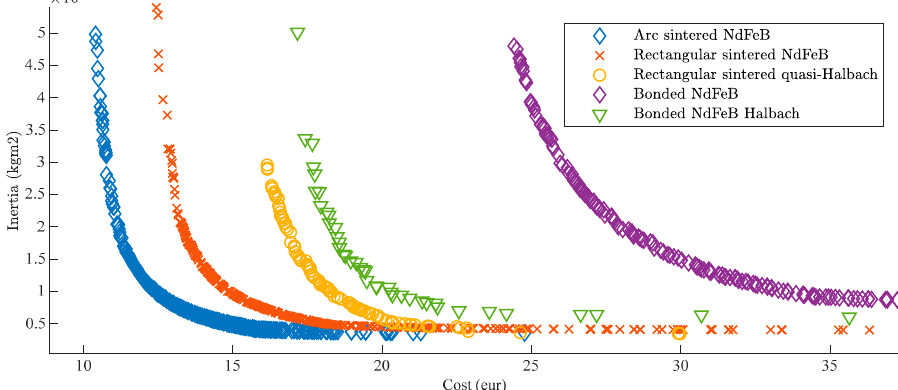
Figure 10. Optimization results plotted as Pareto-fronts for five stator and rotor topologies selected after design space pruning for different energy and stroke specifications.